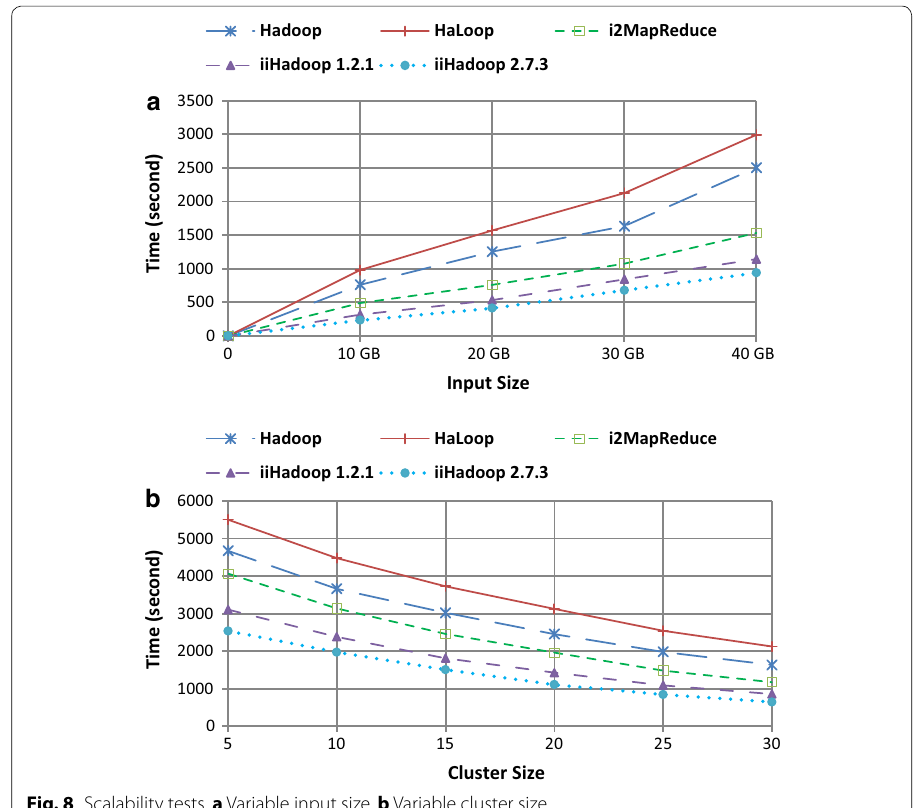
Fig. 8 Scalability tests. a Variable input size. b Variable cluster